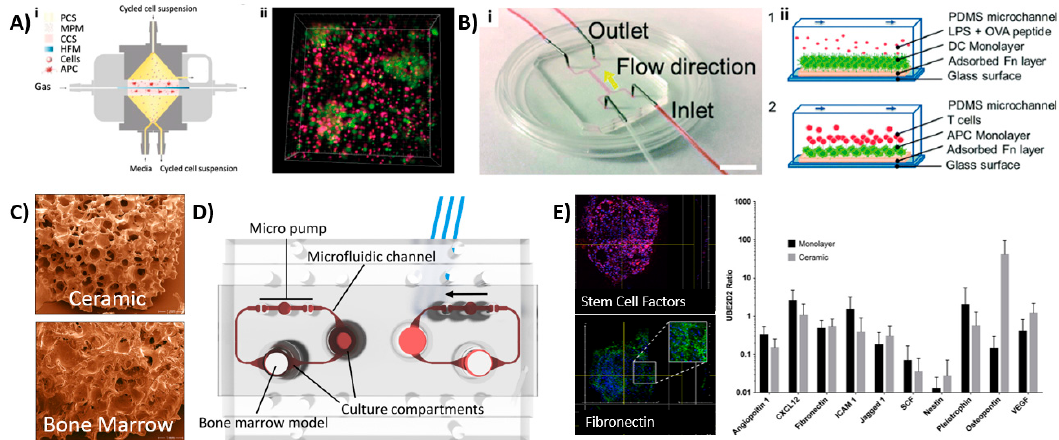
Figure 3. Overview of various LNoC and BM-on-a-chip models. ( A i,ii ) Schematic of the bioreactor, where cell culture media and cell suspensions flow vertically, and the gas supply perfuses horizontally (left). Formation of microorganoids of DCs (red), B cells (red) and PBMCs (pink) after 7 days of perfusion [44]. Reproduced from Ref. [44] with the permission from Elsevier. ( B i,ii ) A LNoC composed of one main flow channel with 2 inlets and 2 outlets (left). Cross sectional view of a schematic showing the DC–T-cell interactions during flow. 1—Dendritic monolayer with LPS or OVA activation to mimic the inflammatory response, 2—T-cell loading and interactions with DCs. (right) [48]. Reproduced from Ref. [48] with permission from The Royal Society of Chemistry; ( C – E ) BM-on-a-chip from Sieber et al. [56]. Copyright 2017 Wiley. Used with permission from Sieber et al . , Bone marrow-on-a-chip: Long-term culture of human hematopoietic stem cells in a three-dimensional microfluidic environment, Journal of Tissue Engineering and Regenerative Medicine, Wiley [56]; ( C ) scaffold used to culture the MSCs (top) compared with human BM (bottom); ( D ) schematic figure of the BM-on-a-chip with possibilities for other organ implantation, resulting in a multiorgan-on-a-chip device; ( E ) immune function of the device, depicting the stem cell factor immunoexpression and fibronectin immunoexpression, as well as the expression of certain BM markers and BM niche cells, such as nestin + and osteopontin. APC—antigen presenting cells; CCS—central culture space; DC— dendritic cells; HFM—hollow fiber module; LPS—lipopolysaccharide; MPM—microporous